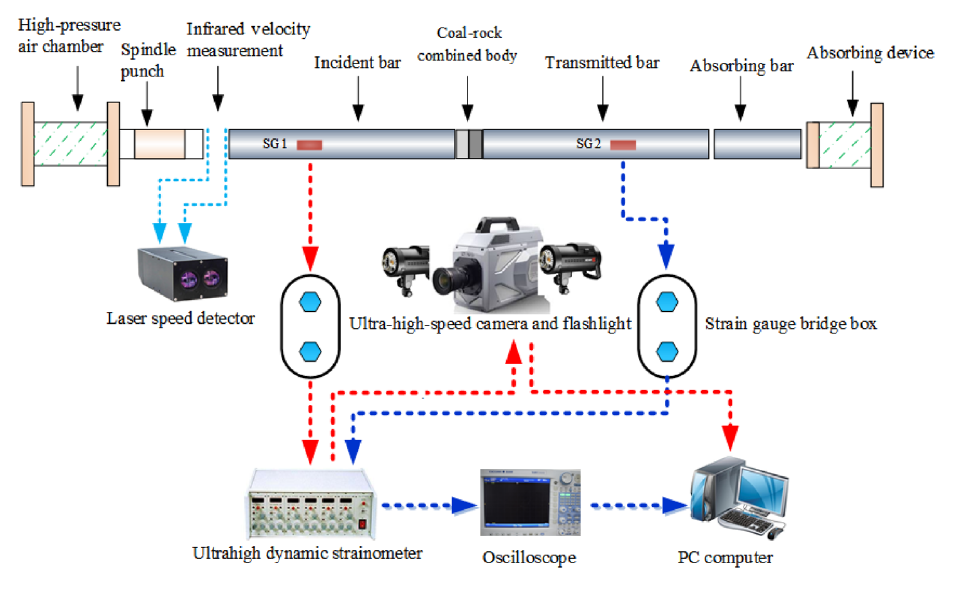
Figure 3. The SHPB test